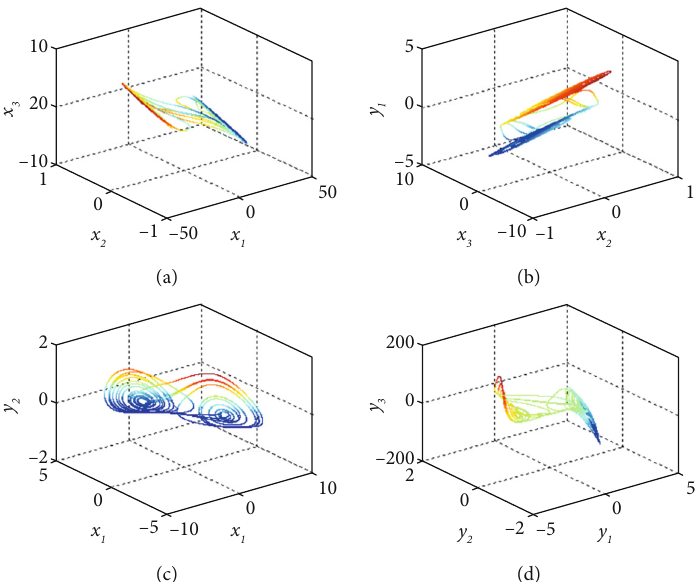
Figure 15: The chaotic trajectory of the unidirectionally coupled Chua ’ s circuit with the high-order polynomial manifold y = (cid:2) T in 3D phase space: (a) x ½ x , x + x 2 , x 3 1 2 2 3